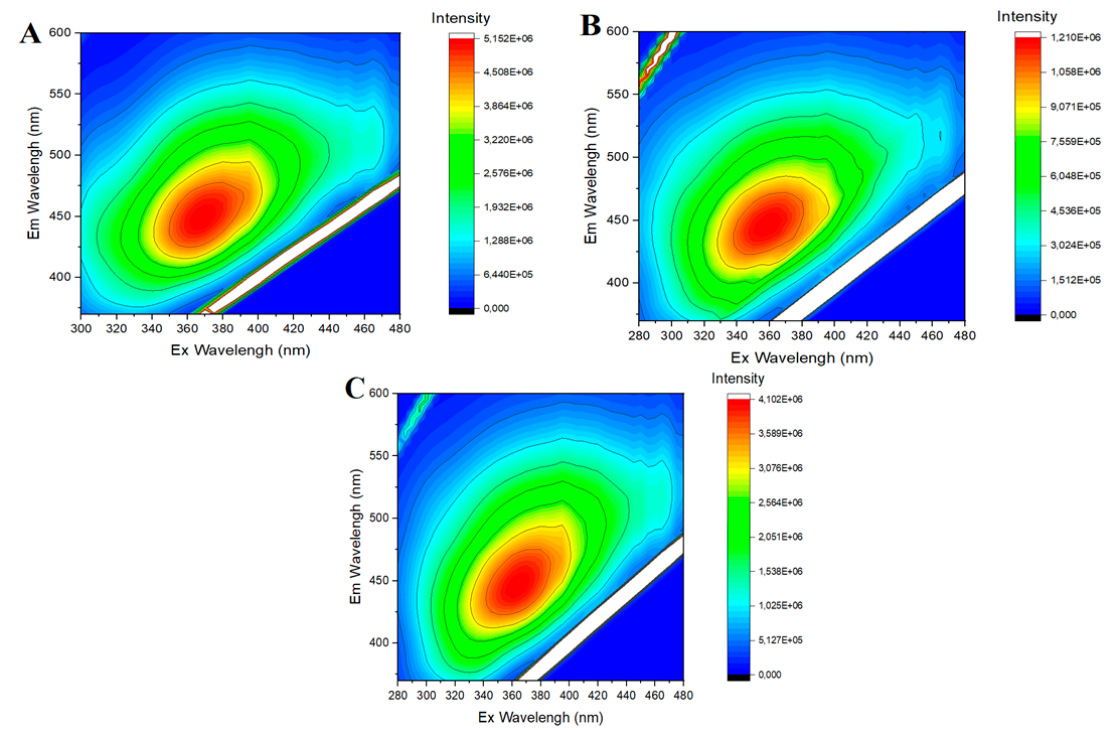
Figure 3. Two-dimensional excitation-emission matrices (EEMs) for decaf-CDs ( A ), rossio-CDs ( B ) and prestige-CDs ( C ).